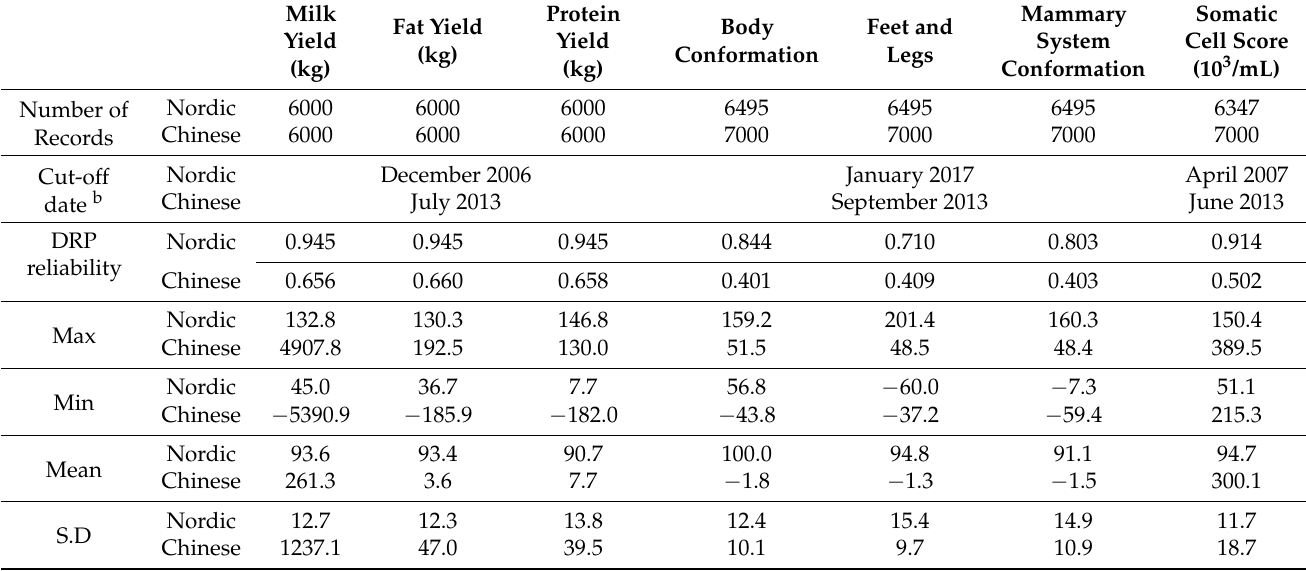
Table 1. Descriptive statistics of DRP a regarding the Chinese and Nordic Holstein